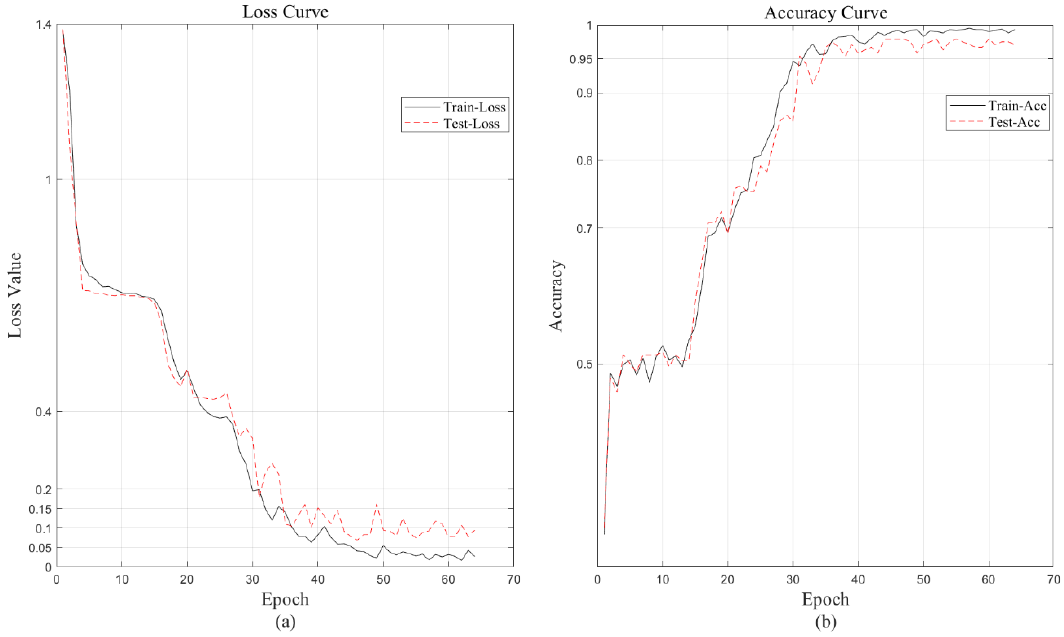
Figure 9. Loss curve and accuracy curve: ( a ) loss curve, ( b ) accuracy curve.